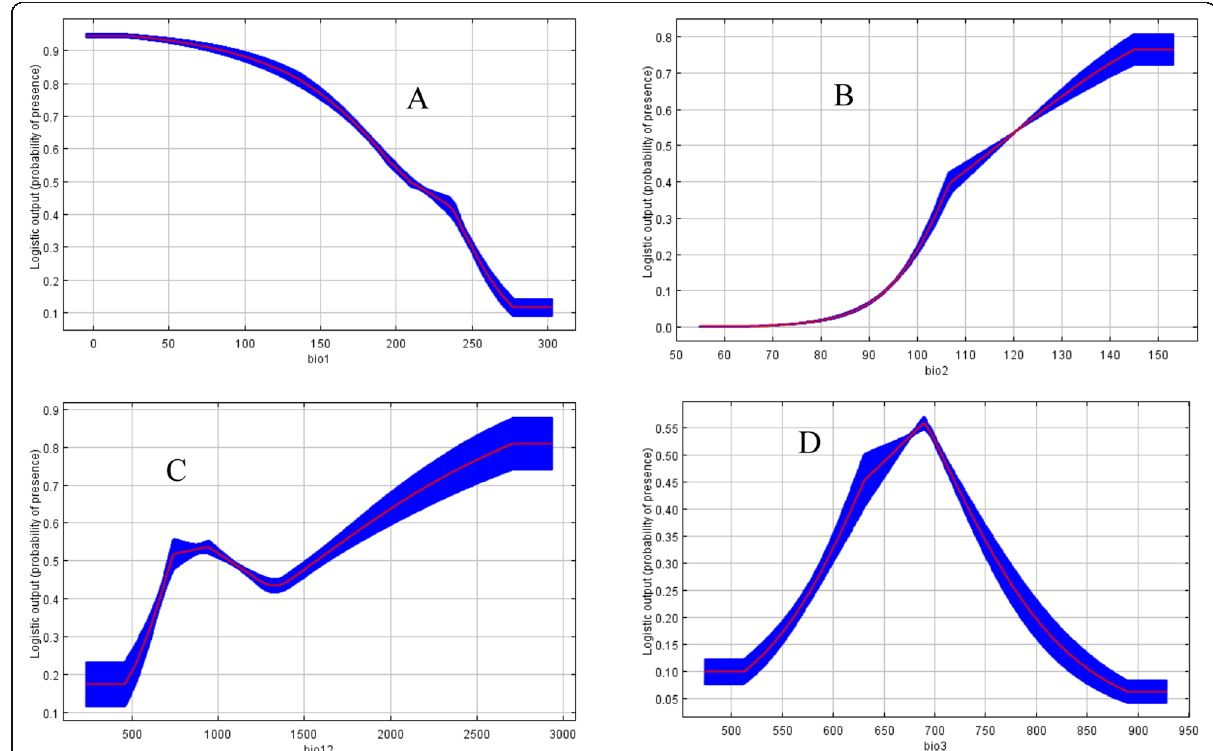
Fig. 2 Response of V. destructor to environmental variables. a Mean diurnal range in temperature (factor 10). b annual mean temperature (factor 10). c Annual mean rainfall. d Isothermality (times